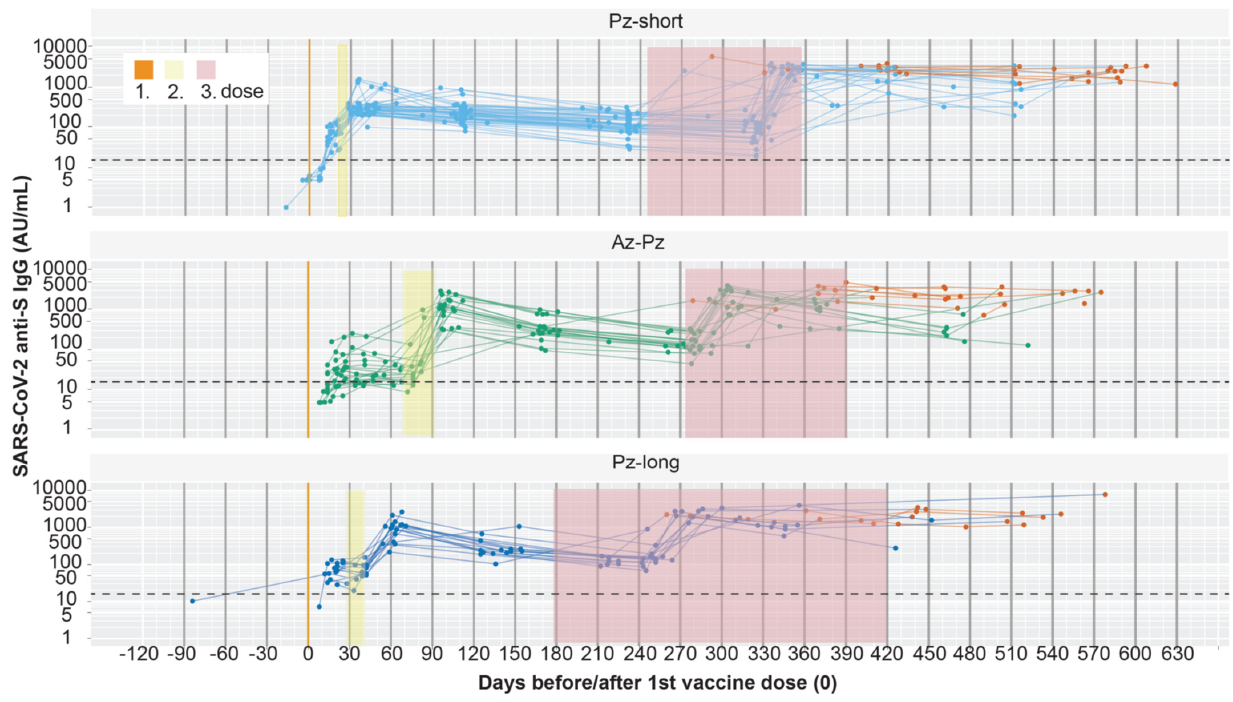
Figure 2. The dynamics of anti-S IgG following vaccination: timeline of individual participants. Anti-S IgG (AU/mL) was measured in individual participants over time and normalised at the first vaccine dose (vertical orange line). The assay positive threshold is marked with a dashed line. Each participant is represented by a line joining their measured values (light blue, green, and dark blue dots). Red dots indicate that the serum sample is analysed after a reported infection based on either a self-performed positive rapid antigen test, a positive PCR test, or detection of anti-N IgG. The time interval for the second and the third dose is shown in yellow and pink, respectively. Between 13 and 21 days post vaccination, seroconversion is detected in all participants in the Pz-short and Pz-long group, but not in the Az-Pz group. The anti-S IgG response over time, normalised at the second dose, is shown in Figure S2.